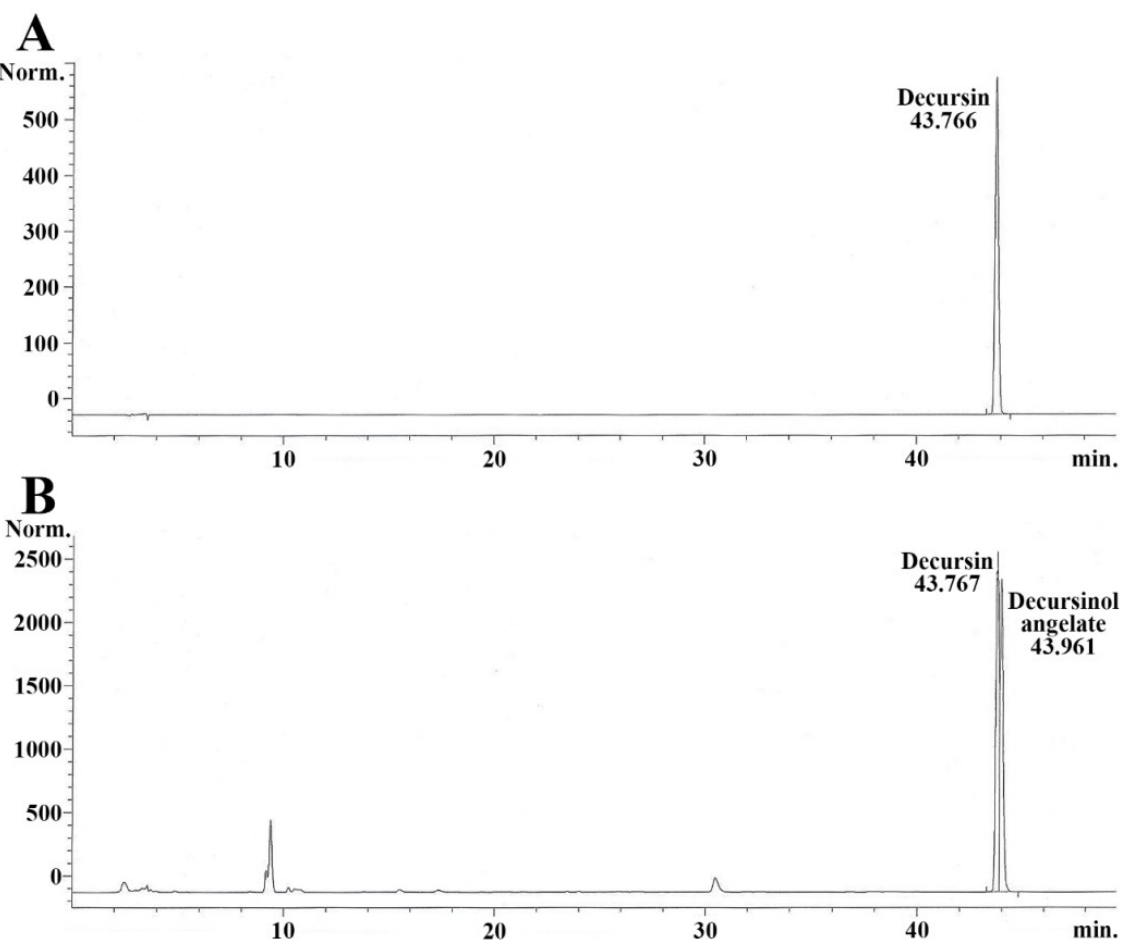
Figure 2. Representative HPLC chromatograms of standard decursin ( A ) and AGNE ( B ). Retention time of the standard decursin is 43.766 min and the retention times of the AGNE are 43.767 min (decursin) and 43.961 min (decursinol angelate), respectively.